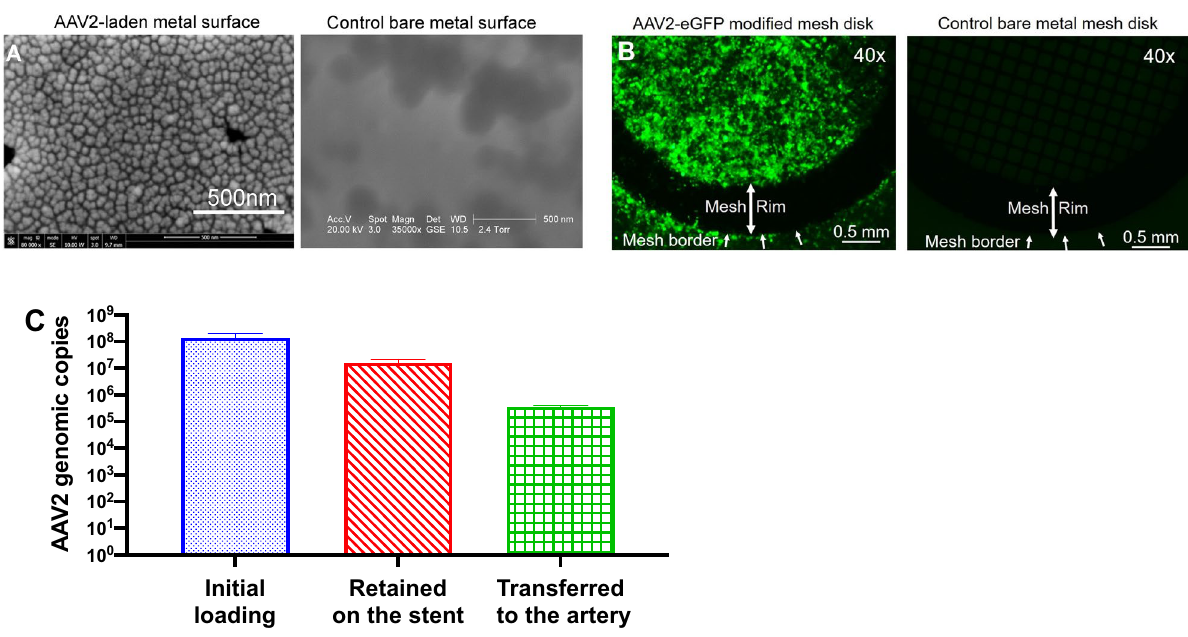
Figure 4. Polybisphosphonate/protein G/antibody-based affinity immobilization of AAV2 particles on stainless steel meshes and cobalt/chromium stents with subsequent vector release and cell transduction. ( A ) Scanning electron microscopy images of AAV2 particles immobilized on the surface of a stainless steel mesh disk (left panel) vs control bare metal disk (right panel). ( B ) Underlying HEK-293 cells were transduced by placement of the mesh disk formulated with AAV2-eGFP (left panel) compared to non-transduced cells treated with the control bare metal mesh disk (right panel). ( C ) Immobilized AAV2 particles were disengaged from the not deployed stents, from the stents deployed in the pig coronary arteries and extracted from the arterial tissue underlying deployed stents. The viral DNA was isolated using a QIAamp DNA minikit and amplified in RT-PCR reaction with AAV2-specific primers. The number of AAV2 genomic copies was quantified using a calibration curve constructed with a known amount of AAV2